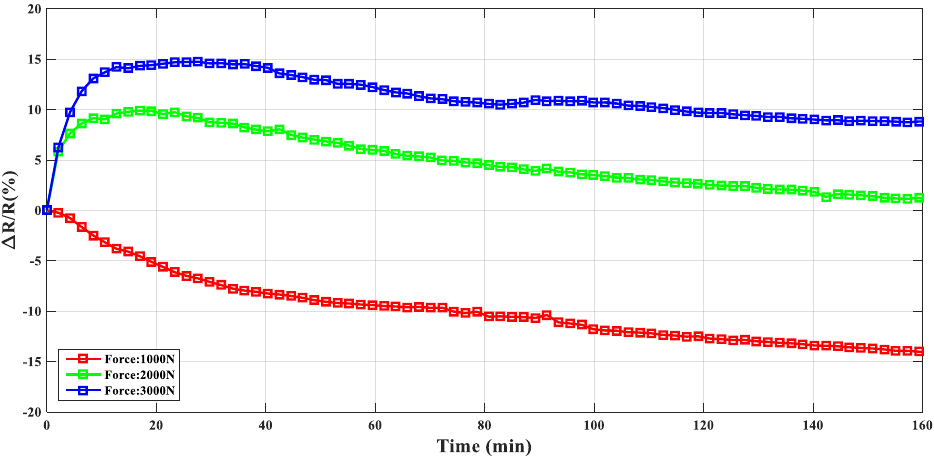
Figure 5. Comparison of the resistance changing ratio with different holding force at 100 °C .